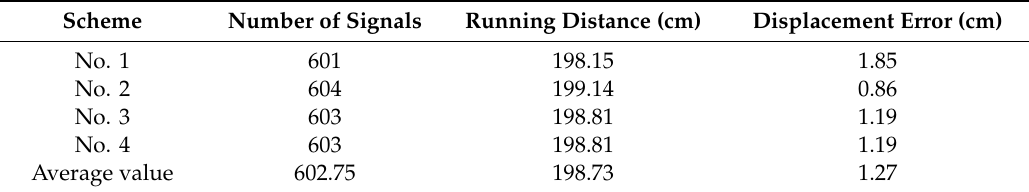
Table 1. Pulse data output from the Hall sensor.